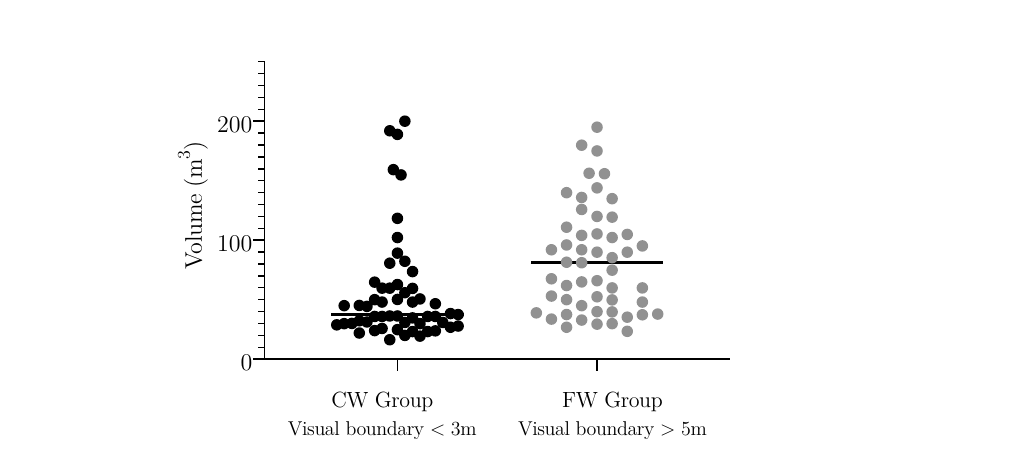
Figure 3. Estimated room volume of participants in each group (CW group: M = 37.5 m 3 ; FW group: M = 81.7 m 3